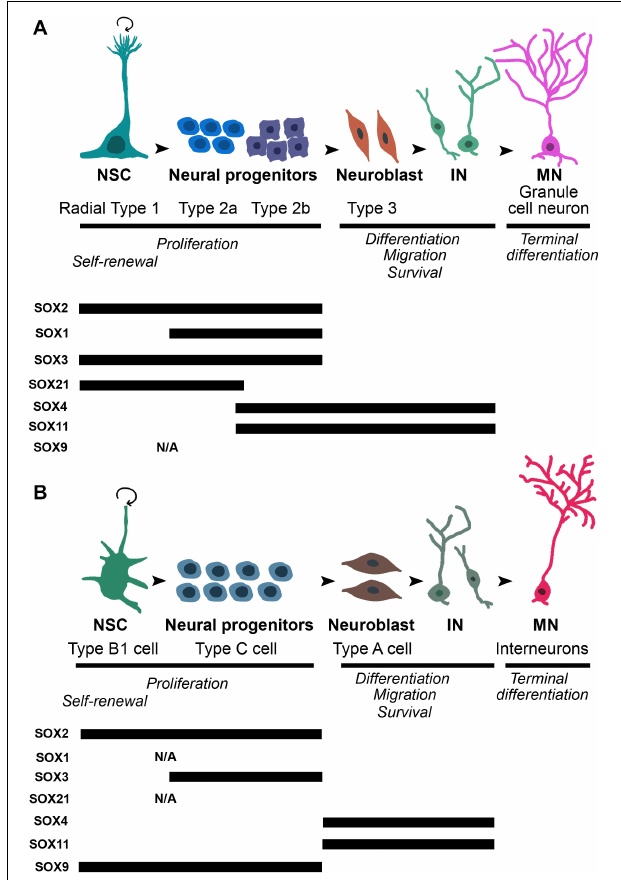
FIGURE 4 | The dynamic expression profiles of selected SOX proteins during different stages of differentiation in neurogenic regions of adult brain: SGZ of dentate gyrus of the hippocampus and SVZ in the later wall of lateral ventricles. (A) Upper panel: the schematic illustration of the main stages of adult neurogenesis in SGZ. Radial type 1 cells, which correspond to neural stem cells, give rise to high proliferative Type 2 cells (first 2a, followed by 2b) which further generate Type 3 neuroblasts. Neuroblasts differentiate into granule neurons that migrate into granular cell layer of dentate gyrus. Lower panel: the schematic summary of the findings regarding the expression of SOX2 (Ferri et al., 2004; Steiner et al., 2006), SOX1 (Venere et al., 2012), SOX3 (Rogers et al., 2013), SOX21 (Matsuda et al., 2012), SOX4 (Mu et al., 2012), and SOX11 (Haslinger et al., 2009; Mu et al., 2012). (B) Upper panel: the schematic illustration of the main stages of adult neurogenesis in the SVZ. Neural stem cells, named as Type B1 cells upon activation generate high proliferative cell population of progenitors - Type C that give rise to Type A neuroblasts. Neuroblasts migrate through rostral migratory stream of the olfactory bulb where they differentiate into interneurons. Lower panel: the schematic summary of the findings regarding expression of SOX2 (Ferri et al., 2004), SOX3 (Rogers et al., 2013), SOX4 (Pennartz et al., 2004), SOX11 (Haslinger et al., 2009), and SOX9 (Cheng et al., 2009). NSC, neural stem cell; IN, immature neuron; MN, mature neuron; N/A, data not